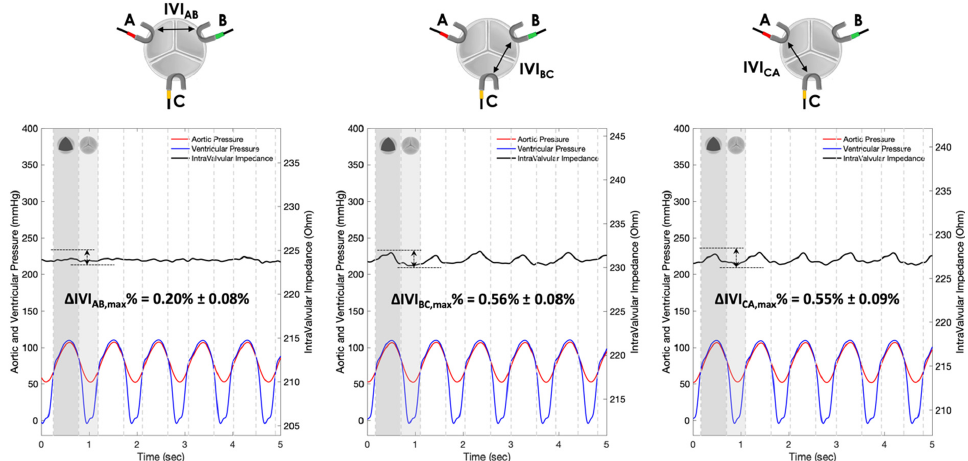
Figure 12. IVI measurements recorded for the three pairs of electrodes of Prototype 3 under normal leaflet dynamics: AB ( left ), BC ( center ) and CA ( right ). For each pair of electrodes of Prototypes 1, 2 and 3, the maximum percent variation of the impedance module ( 𝛥𝐼𝑉𝐼 (cid:3040)(cid:3028)(cid:3051) % ) was then calculated following Equation (1) (Table 1). Table 1. For each pair of electrodes (AB, BC and CA) of the three prototypes, maximum percent variation of the impedance module ( 𝛥𝐼𝑉I (cid:3040)(cid:3028)(cid:3051) % ), reported as 𝑀𝑒𝑎𝑛 𝑉𝑎𝑙𝑢𝑒 (cid:3399) 𝑆𝐷 , is shown for the “physiological” working condition. Prototypes